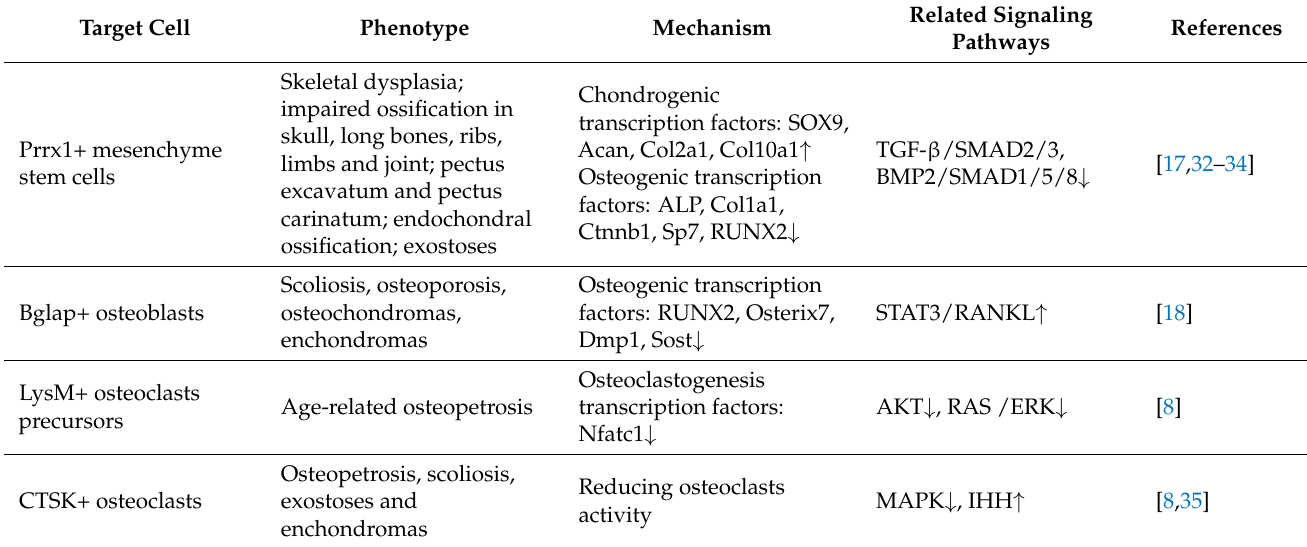
Table 1. Mouse models of SHP2 deletion with skeletal